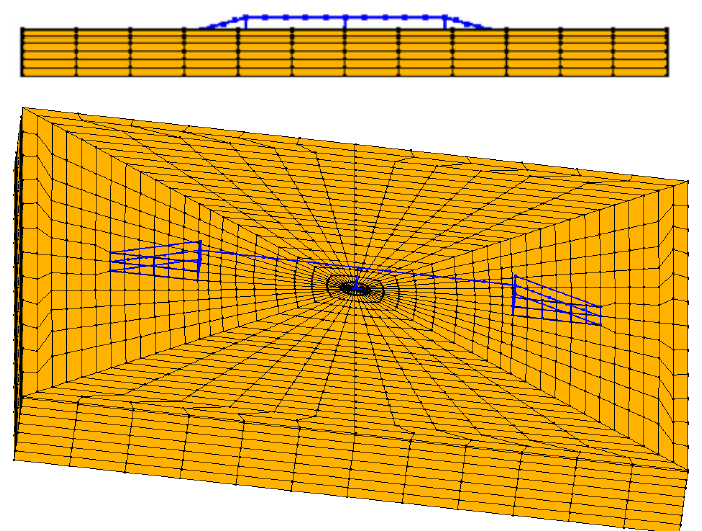
Figure 2. Numerical model.